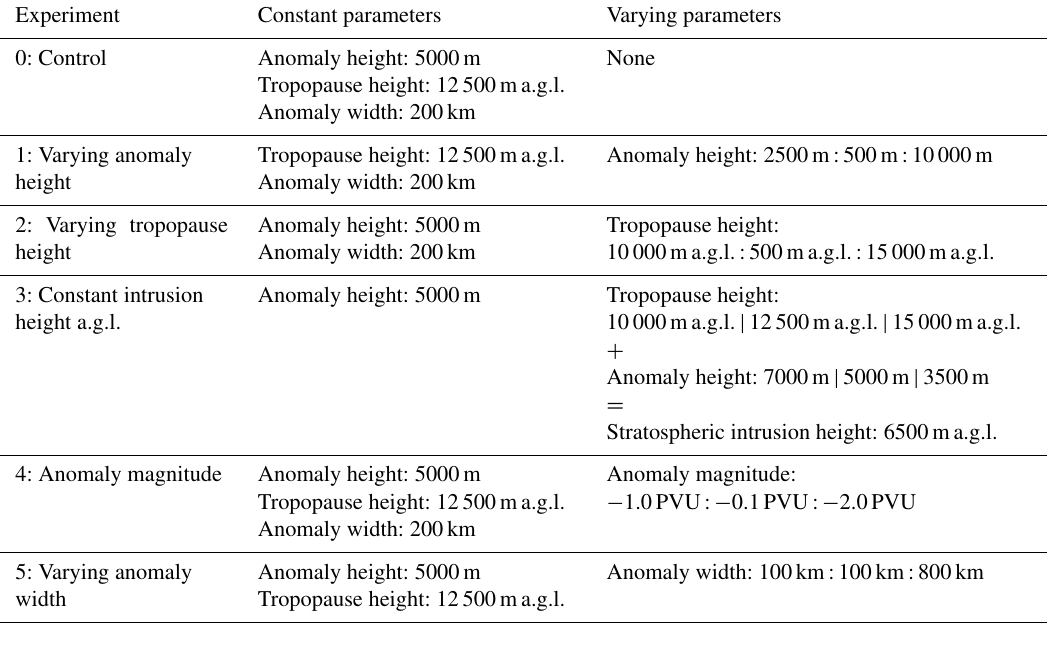
Table 1. Table of all experiments performed using the PV inversion algorithm. In each experiment, the basic state remains the same with varied dimensions of the PV anomaly, magnitude of the PV anomaly and the height of the dynamical tropopause a.g.l. Experiment